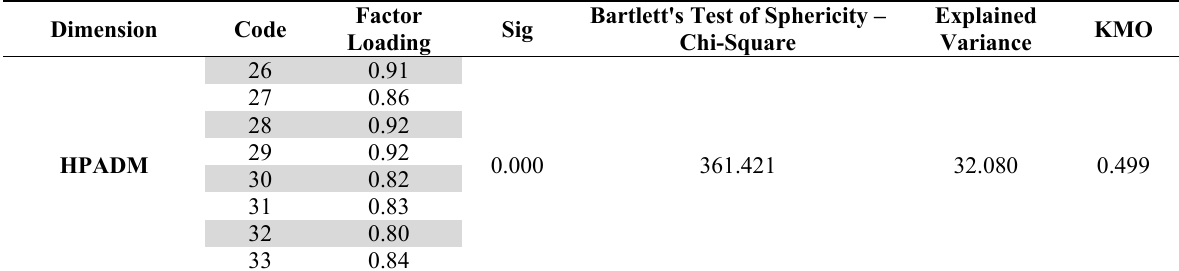
EFA analysis for the items representing the Dependent Variable (healthcare providers acceptance for digital